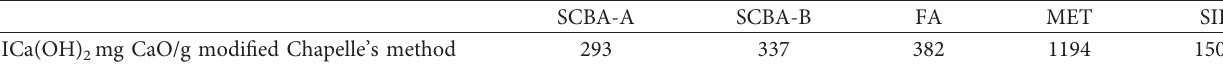
Figure 7: Chemically combined water content (AQC) and portlandite (Ca(OH) Table 4: Data of modified Chapelle’s method for all mineral